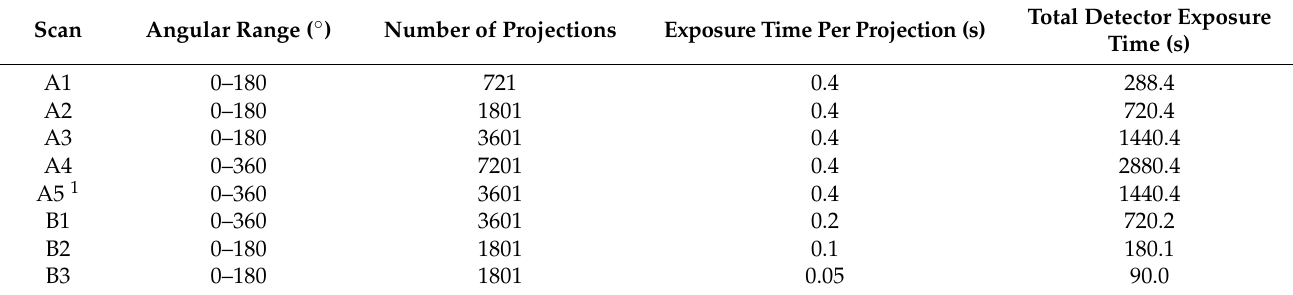
Table 1. XCT scan parameters and threshold value for binarisation (Section